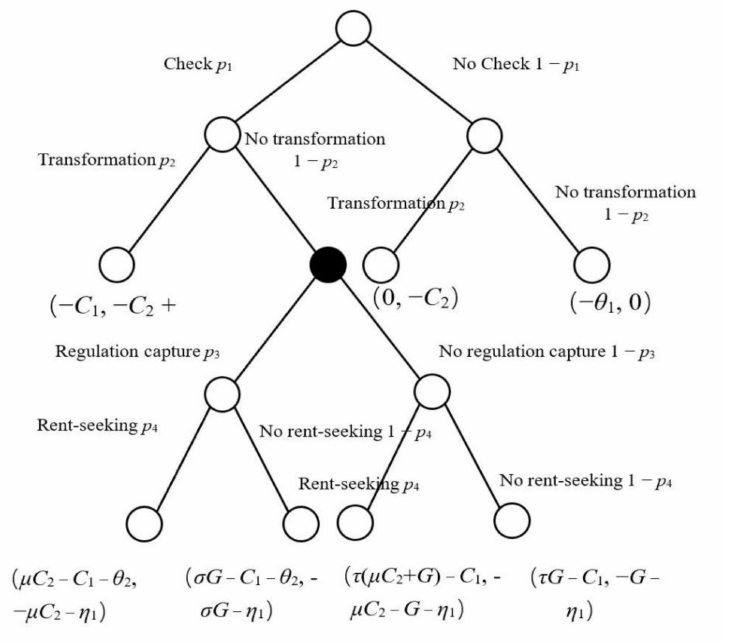
Figure 2. Dynamic game model between environmental regulators and dairy farming